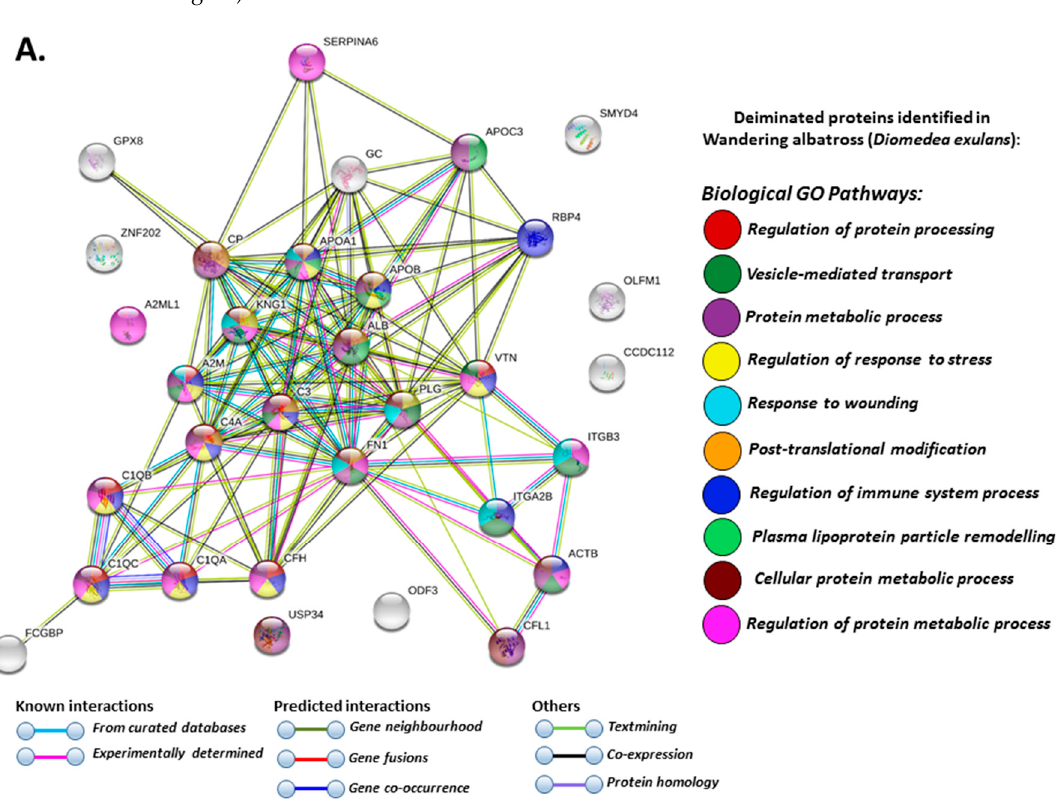
Figure 7. Protein–protein interaction networks of deiminated proteins identified by F95 enrichment in plasma of wandering albatross ( Diomedea exulans ). Reconstruction of protein–protein interactions based on known and predicted interactions of human homologue proteins to proteins identified in wandering albatross, using STRING analysis. ( A ) Biological GO pathways relating to identified